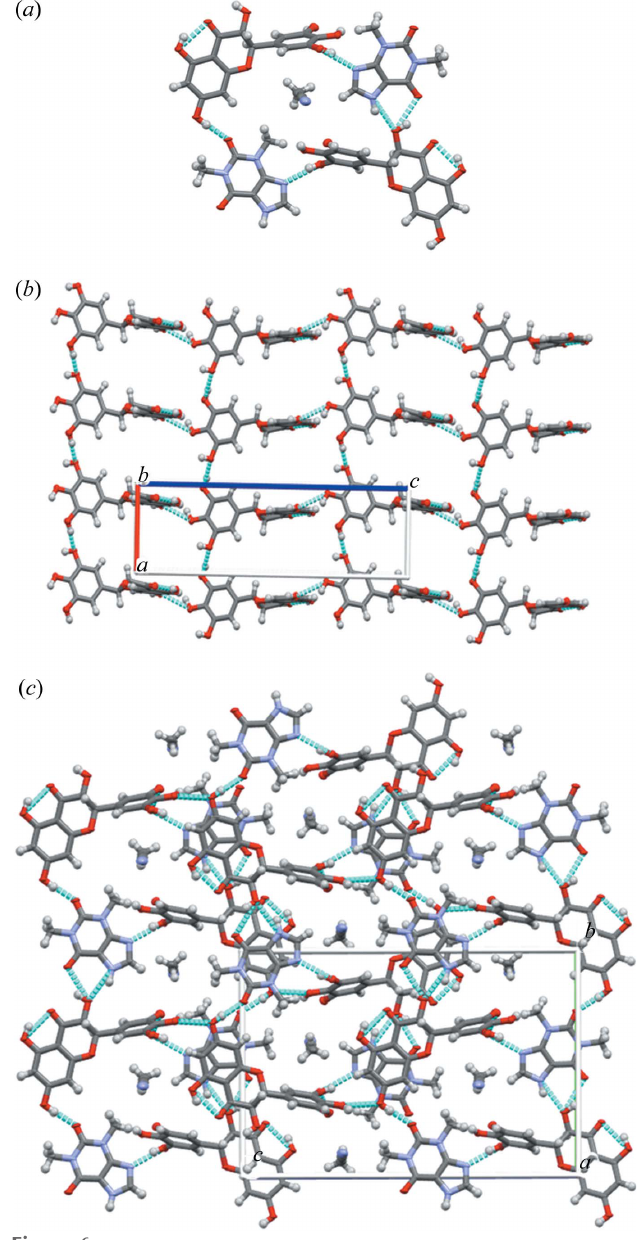
Figure 6 Structure analysis of the R , R -DMY–THE cocrystal. ( a ) Hydrogen- bonding pattern showing the formation of the channel structure with acetonitrile included. ( b ) 3D molecular packing arrangement between pyrogallol–pyrogallol along the a direction and hydrogen bonding arrangement between resorcinol–pyrogallol along the c direction; ( c ) 3D molecular packing with an acetonitrile molecule included, viewed along the a